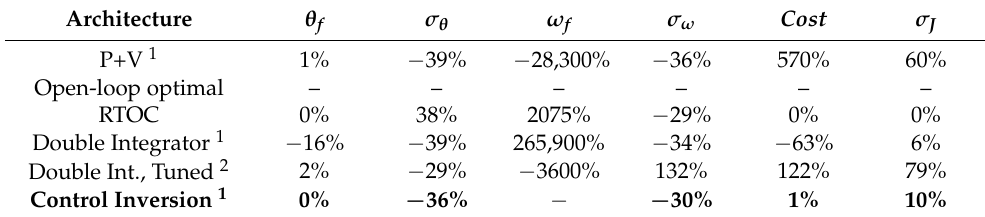
Table 2. Numerical results of Monte Carlo simulations, N = 1000. σ refers to the standard deviation of a quantity. All other numerical results represent the mean over all simulations. Percent differences are compared to the benchmark open-loop optimal